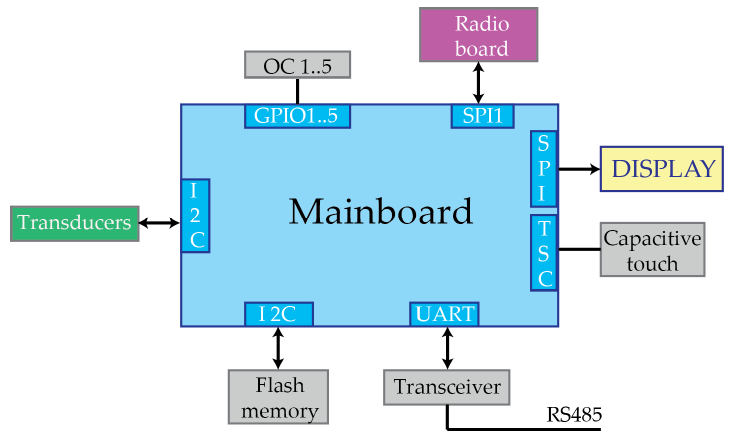
Figure 11. Host module block diagram (OC—optocoupler, GPIO—general-purpose input/output, TSC—touch-sensing controller).